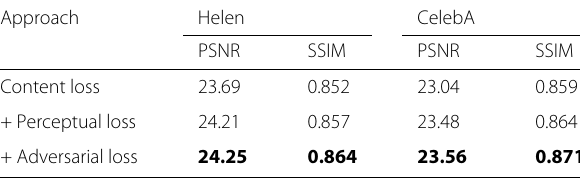
Table 2 Quantitative evaluation for constraints